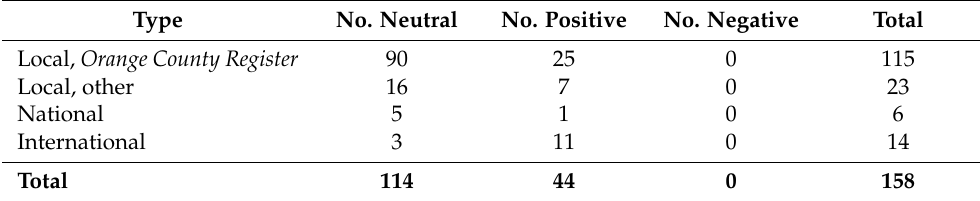
Table 1. Type, number, and tone of articles covering Water Factory 21 or GWRS, 2000–2016. Type No. Neutral No. Positive No. Negative Total Local, Orange County